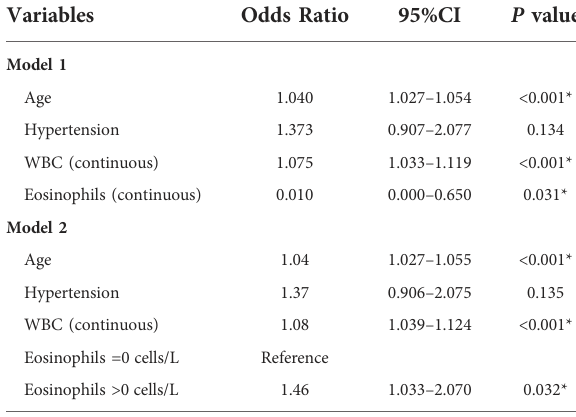
TABLE 3 The effects of different eosinophil levels on the clinical characteristics, primary and secondary outcomes of patients with AAD.